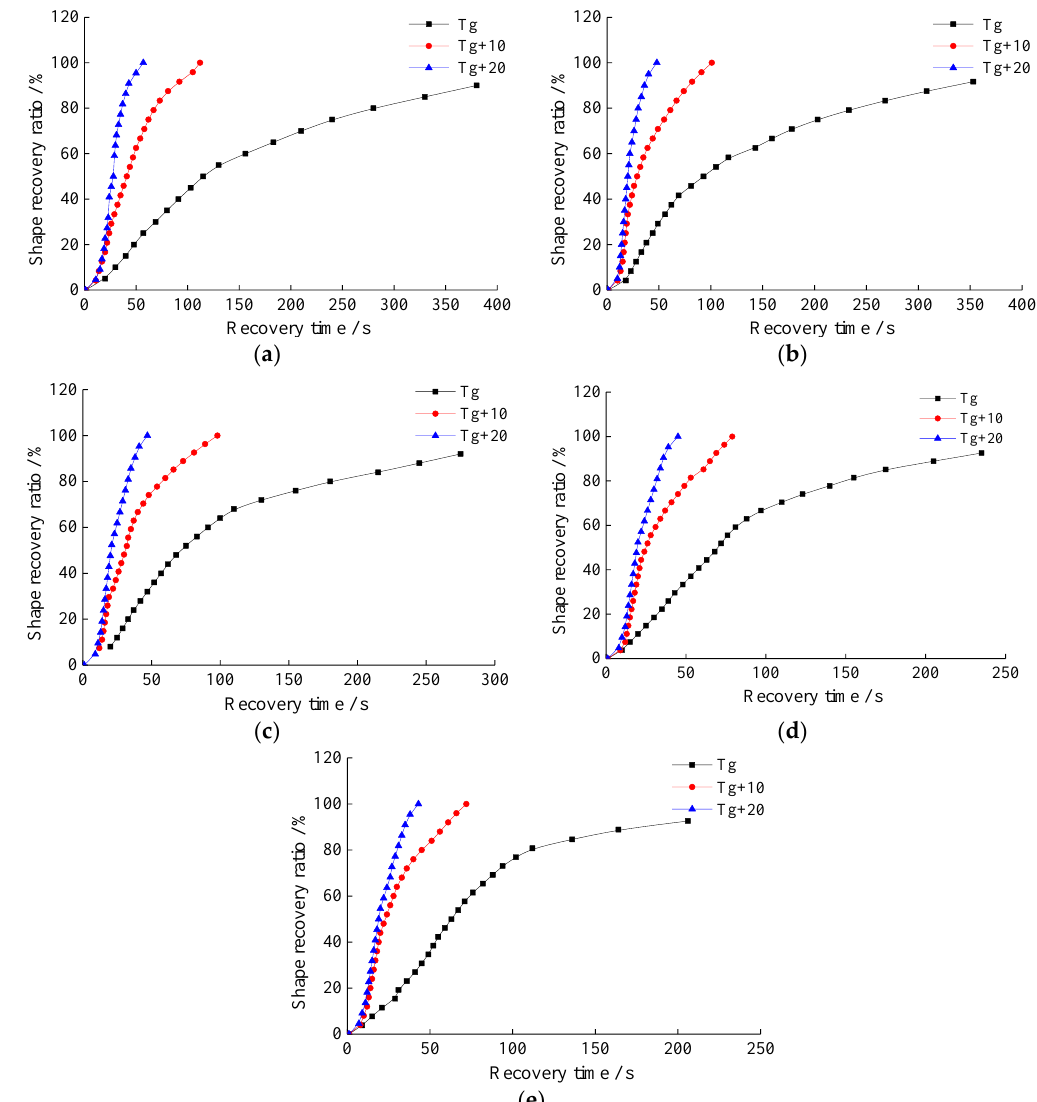
Figure 12. Relationship between shape recovery ratio and recovery time of the SM-HEP-AM: ( a ) JH-230-0.0796; ( b ) JH-230-0.0685; ( c ) JH-230-0.0574; ( d ) JH-230-0.0463; and ( e ) JH-230-0.0353.